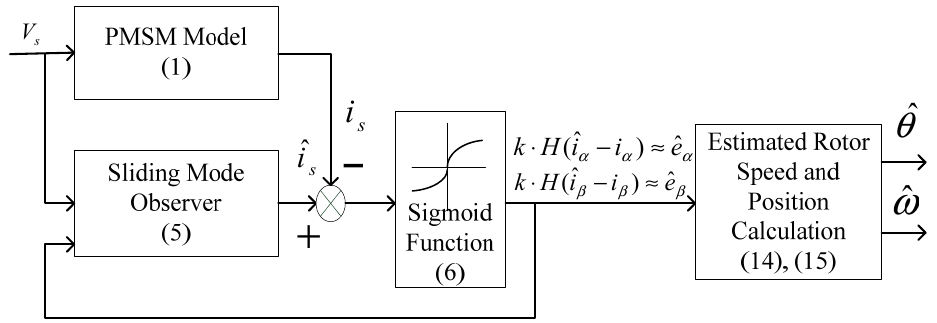
Figure 2. The block diagram of iterative sliding mode observer.